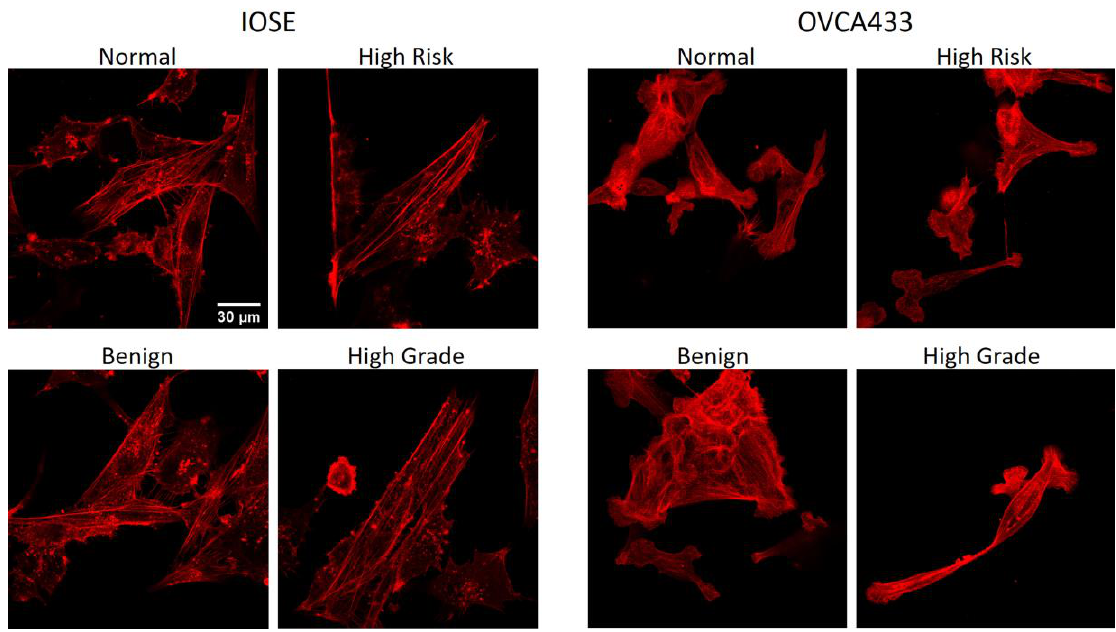
Figure 8. Two-photon excited fluorescence of f-actin filaments of IOSE and OVCA433 cells stained with Texas Red (phalloidin) on image-based patterns. Scale bar = 30 µm.